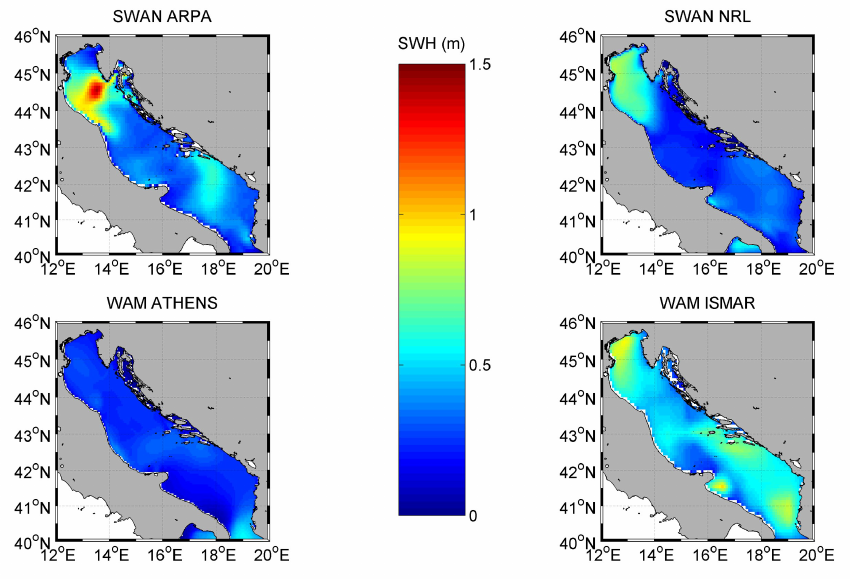
Fig. 3. Wave forecasts for 2 August 2006 at 18:00UTC in the Adriatic